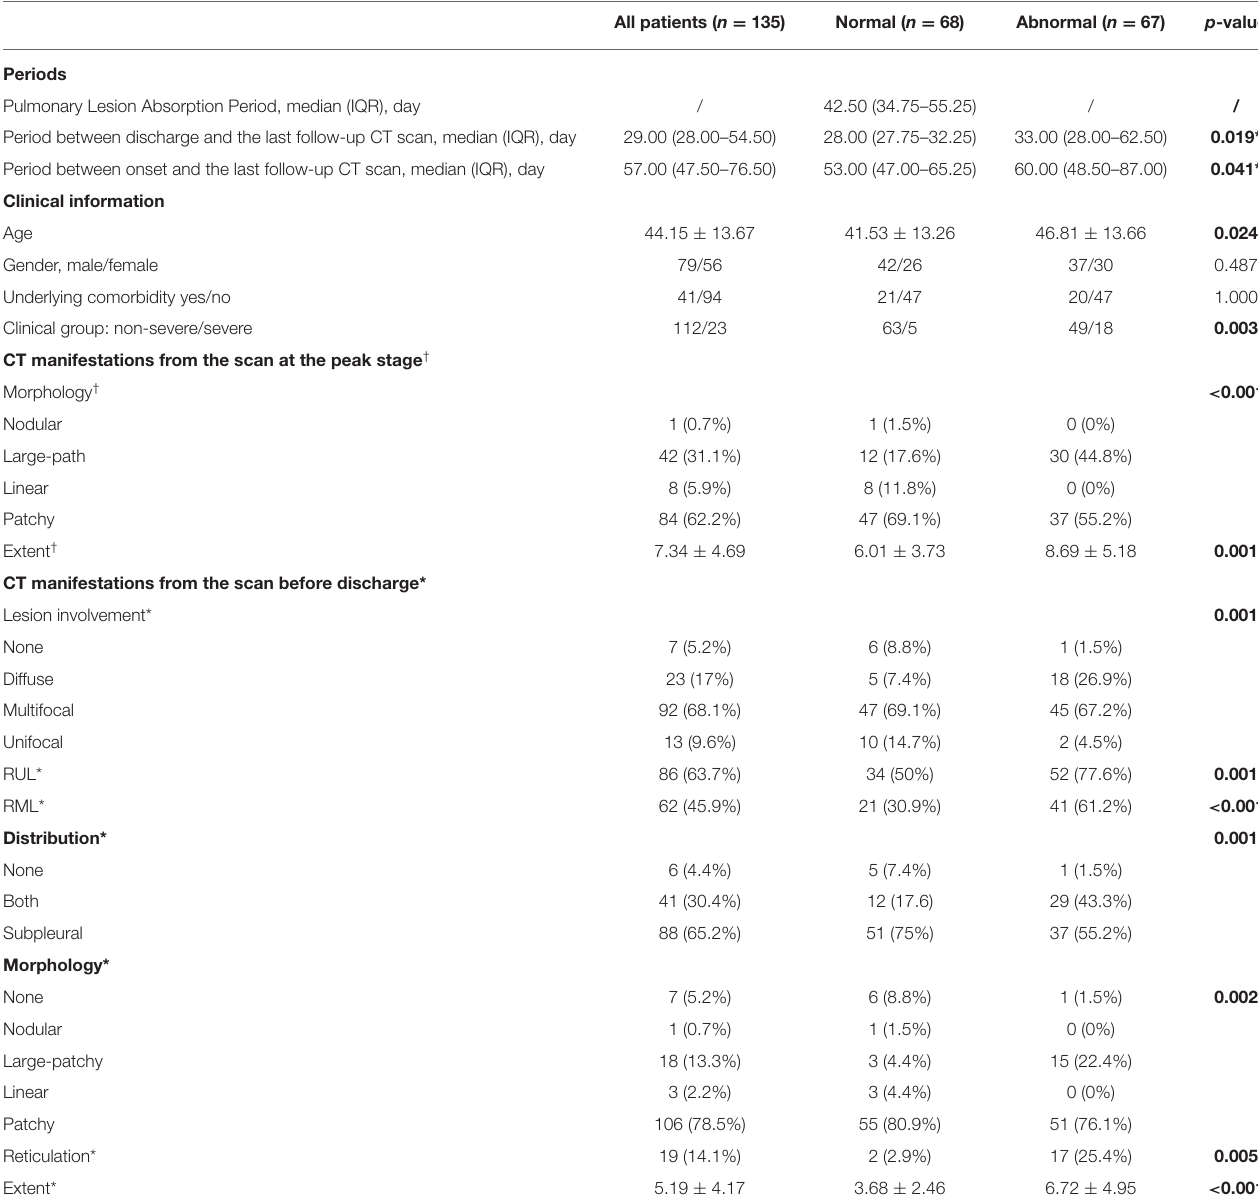
TABLE 3 | The comparison of clinical and CT manifestations during hospitalization between the patients with coronavirus disease 2019 (COVID-19) with normal and abnormal CT findings in the last follow-up scan after discharge. All patients ( n =